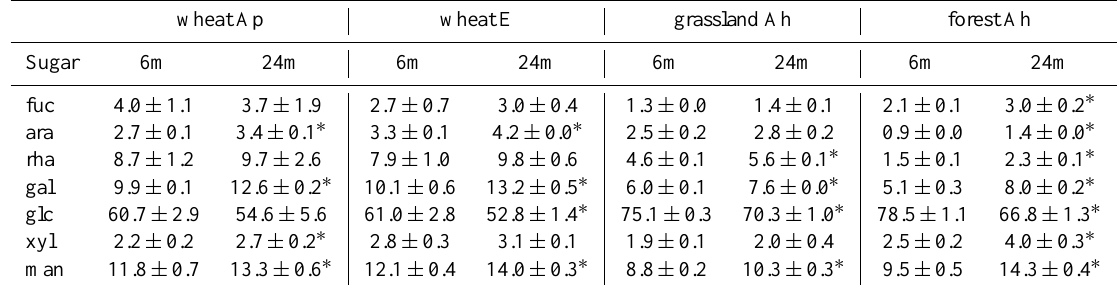
Table 2. Relative distribution of total label derived sugar C [wt%] among different sugars after 6 and 24months of incubation (means ± standard error; n = 3). Significant differences ( p <0.05) between the two sampling times are indicated by an